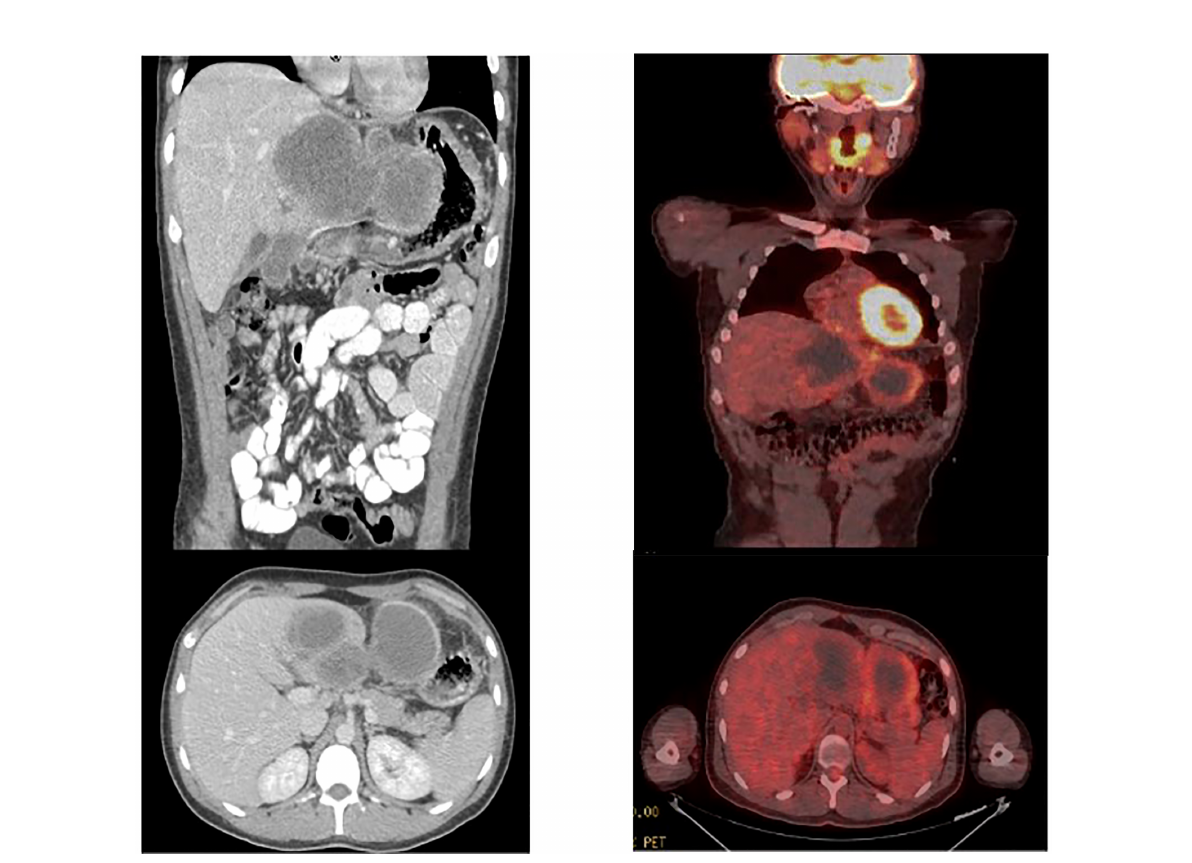
FIGURE 3 CT scan after completion of neodjuvant chemotherapy. Signi fi cant improvement was visualized with a decrease in lesion size to 15 x 7.7 x 8.1 cm. PET scan after completion of neodjuvant chemotherapy demonstrating reduction in size of mass to 14.5 x 6.8 x 8.9 cm as well as decreased FDG avidty of SUV